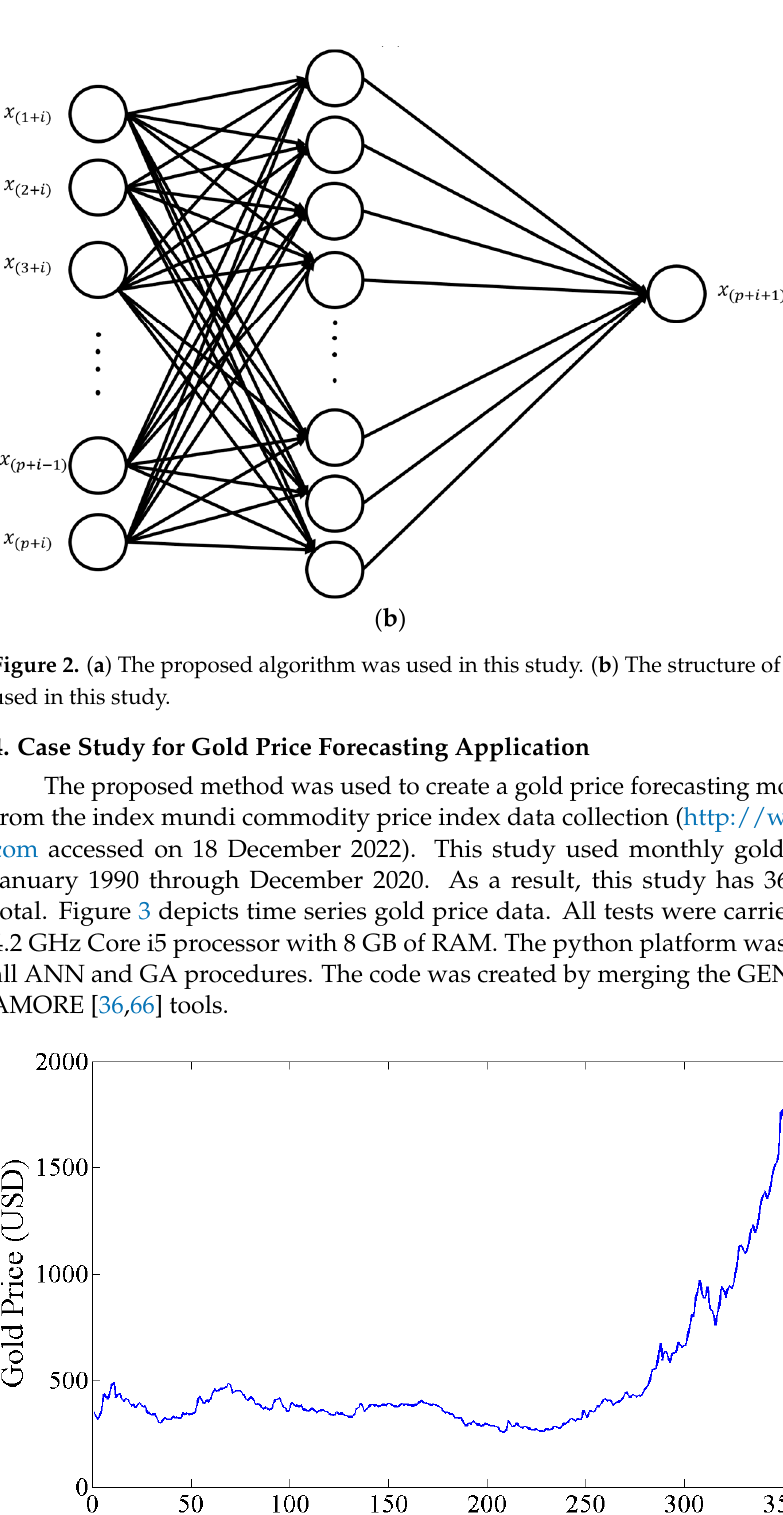
Figure 4. Values of mean entropy for various 𝑇 (cid:3036) size.